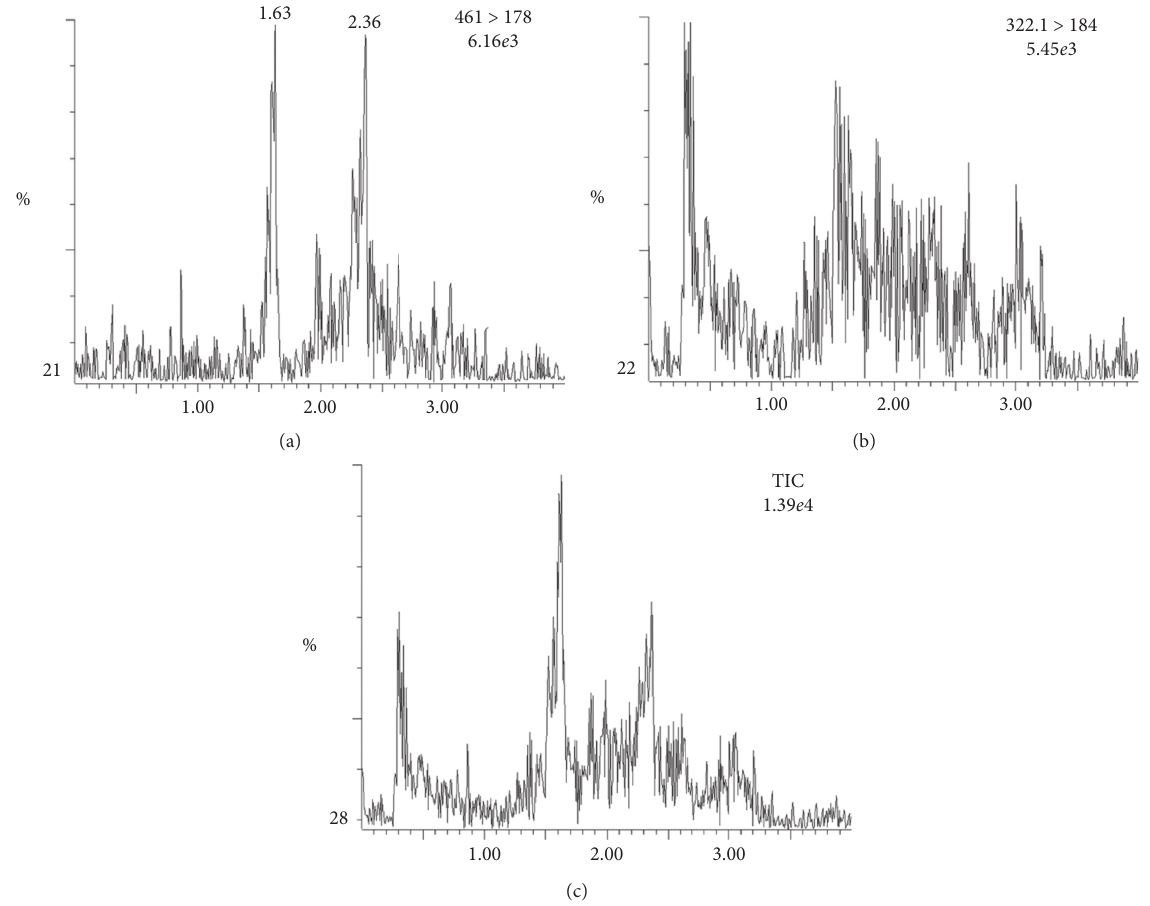
Figure 2: Representative chromatograms of blank plasma sample from a beagle